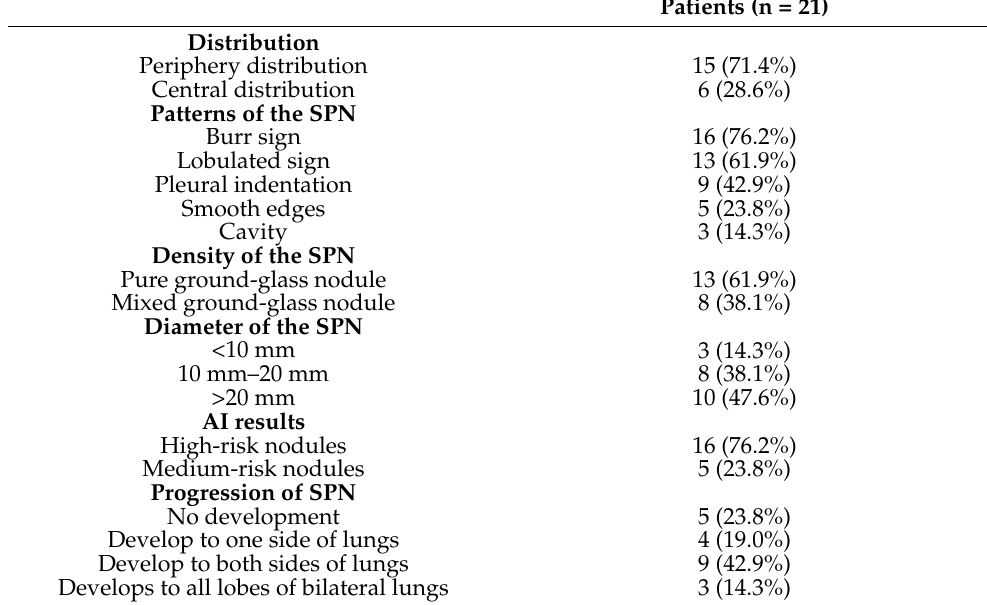
Table 5. CT findings and AI results of COVID-19 patients with